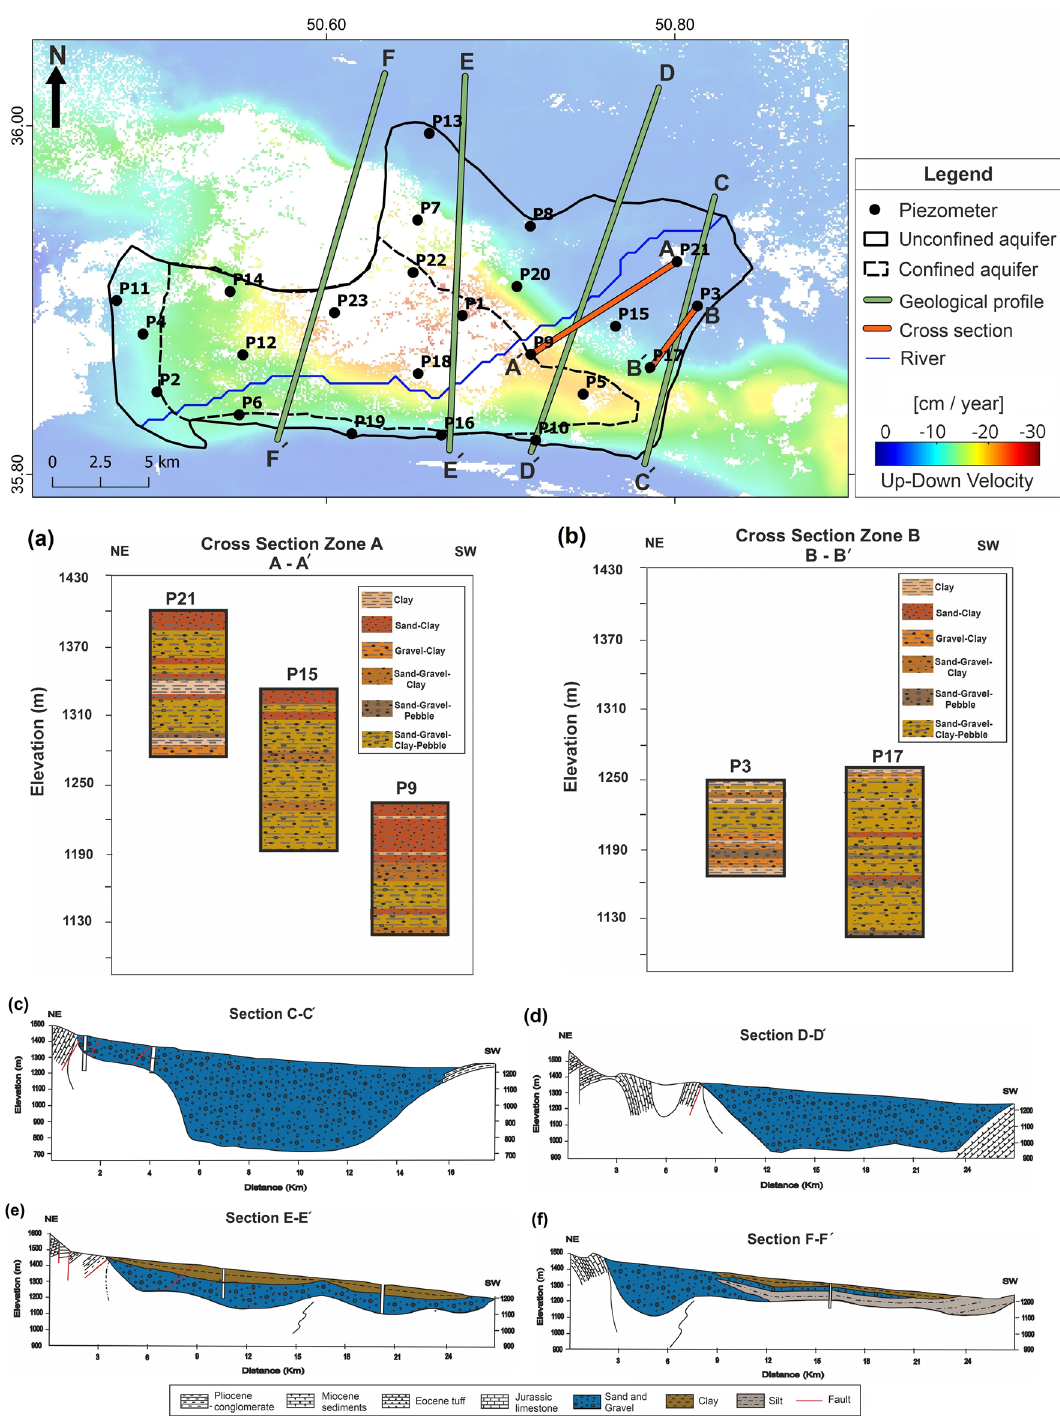
Figure 9. Position of log sections of piezometers and geoelectric sections of confined and unconfined aquifers of Hashtgerd plain for log sections of ( a ) AA’, ( b ) BB’, and geoelectric sections of ( c ) CC’, ( d ) DD’, ( e ) EE’, and ( f ) FF’. This figure was created using the QGIS version Desktop 3.18.1 software (https:// qgis. org/ en/